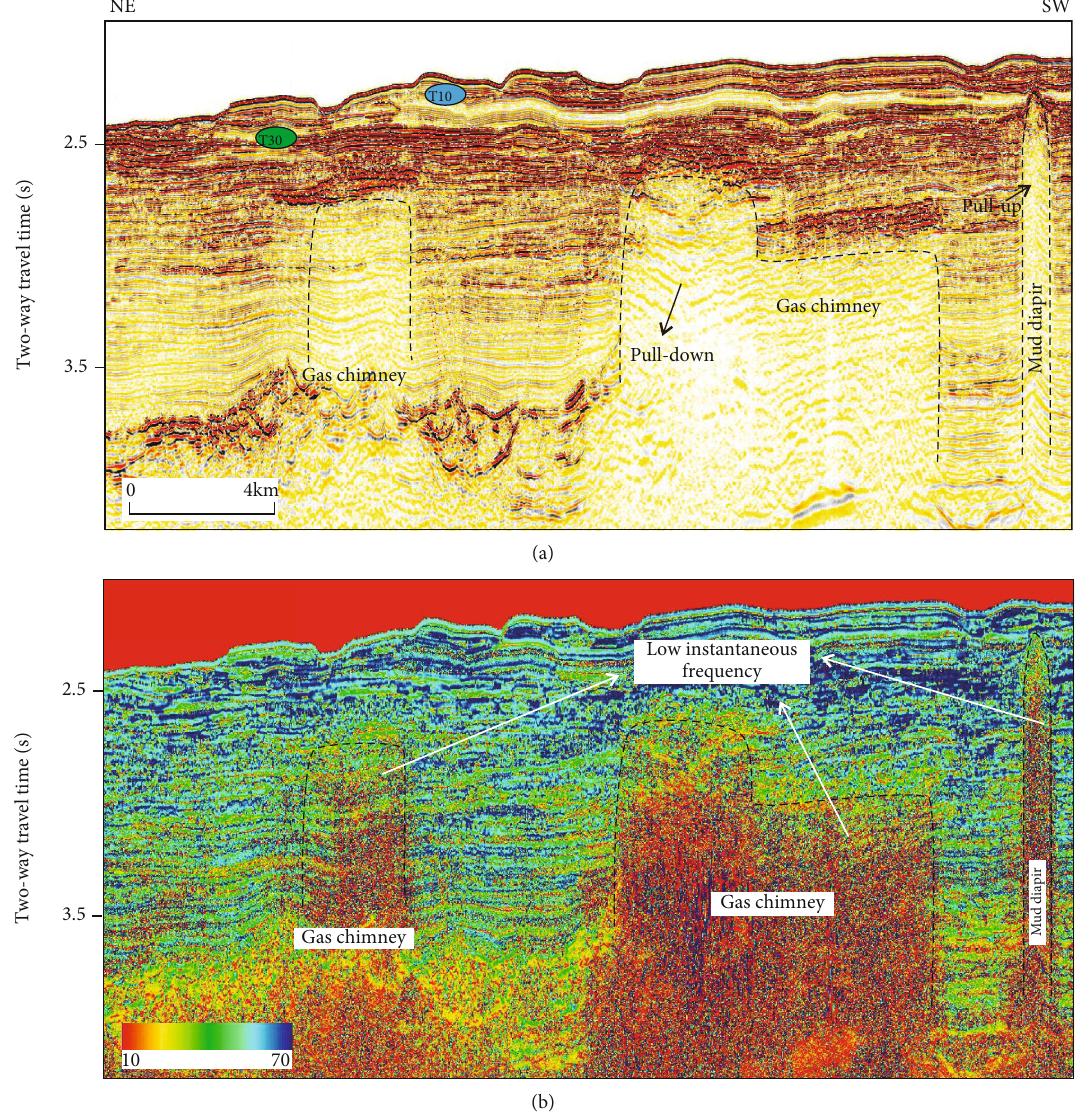
Figure 5: (a) Seismic pro fi le over the Shenhu hydrate exploration area in Baiyun sag of Pearl River Mouth Basin. One mud diapir and two gas chimneys can be recognized in the pro fi le. Mud diapir developed in the Paleogene strata, with a vertical columnar piercing T3 interface and reaching the Miocene strata causing plastic deformation of overlying sediments. (b) Internal appearance of the mud diapir on the instantaneous frequency pro fi le exhibiting a low instantaneous